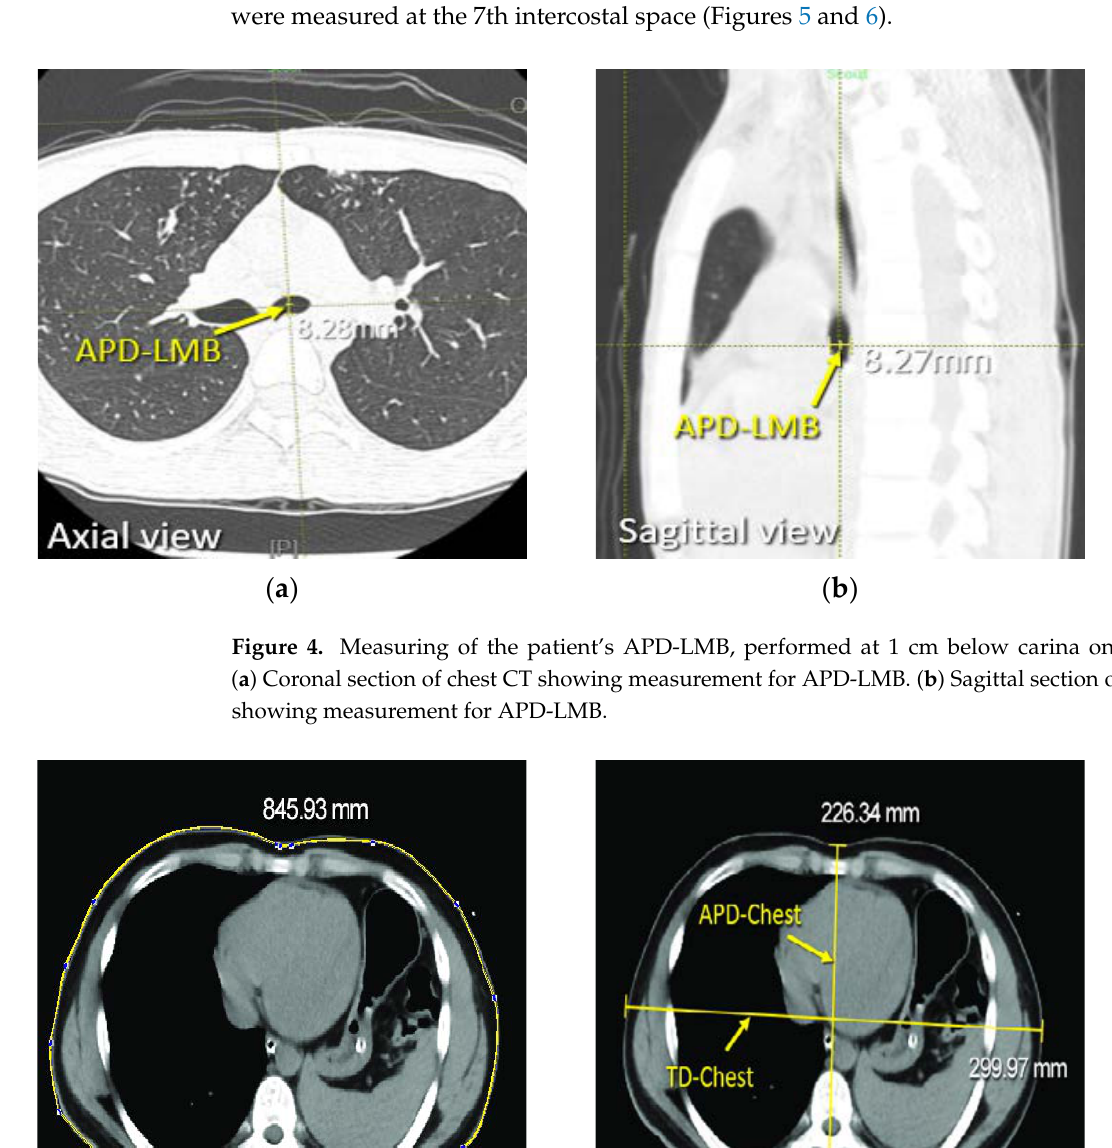
Figure 4. Measuring of the patient’s APD-LMB, performed at 1 cm below carina on chest CT. ( a ) Coronal section of chest CT showing measurement for APD-LMB. ( b ) Sagittal section of chest CT showing measurement for APD-LMB.